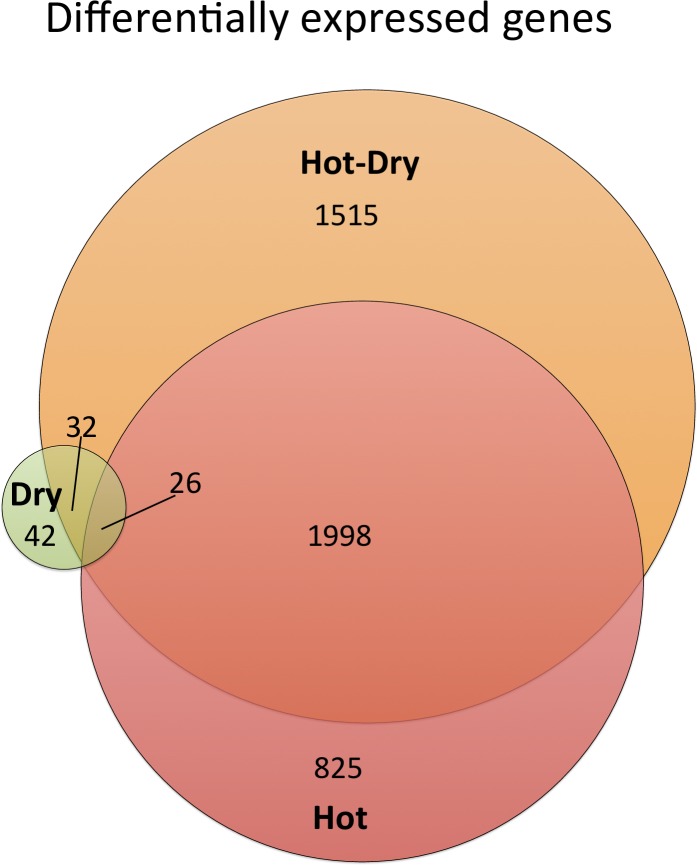
Venn-Diagram showing the number of differentially expressed genes in
three treatments relative to control conditions.Overlapping regions represent genes that were found in more than one
treatment and changed expression levels in the same direction. Sizes of
circles as well as of overlapping regions are proportional to number of
genes.